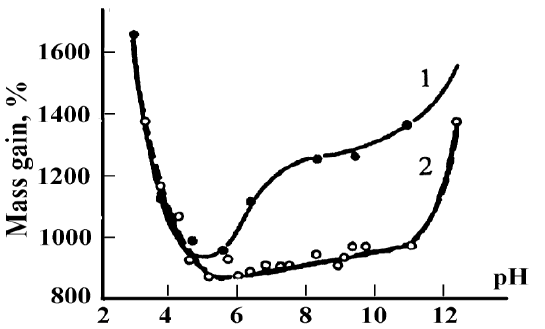
Figure 5. Gelatin swelling curves depending on pH: 1 — for alkaline gelatin, 2 — for acid gelatin. (This figure was made by the author of the given article according to the data presented in